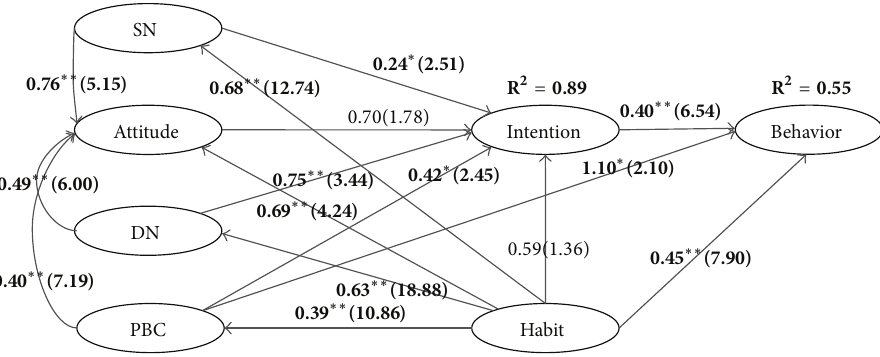
Figure 8: Standardized coefficients between the latent factors using HSR.